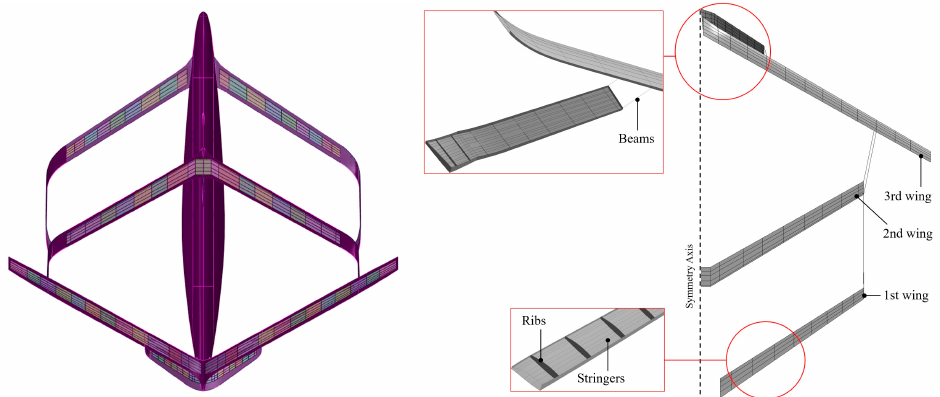
Figure 13. BWA/SL aircraft: Finite element method (FEM) model used for the aero-structural (FSI) computations, with FEM elements of the planform highlighted (( left ): overall view, ( right ): details).